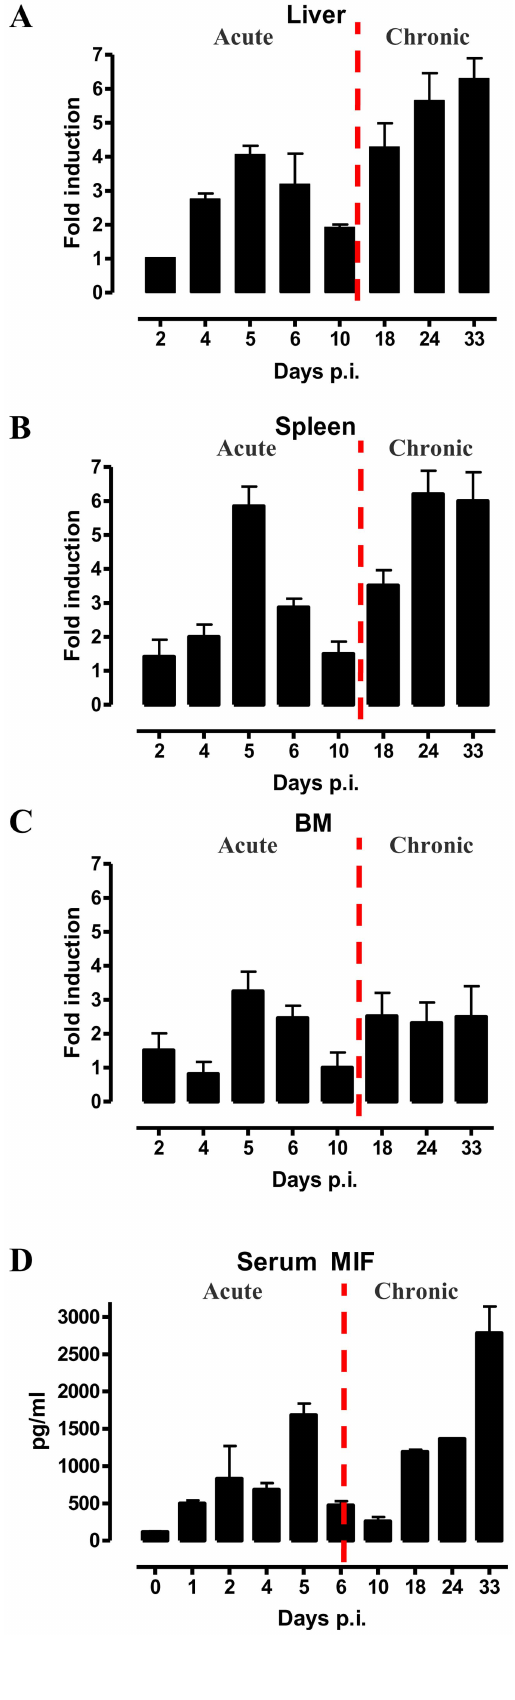
Figure 1. MIF expression exhibits biphasic profiles during T. brucei infection. Mif gene expression levels in the liver (A), spleen (B), bone marrow (BM) (C) and serum MIF protein levels (D) during infection in C57Bl/6 mice. The dashed line delineates the transition from the acute to the chronic phase of infection. Gene expression levels were normalized against s12 and expressed relative to expression levels in non-infected mice. Results are representative for 2–3 independent experiments and presented as mean of 2–3 individual mice 6